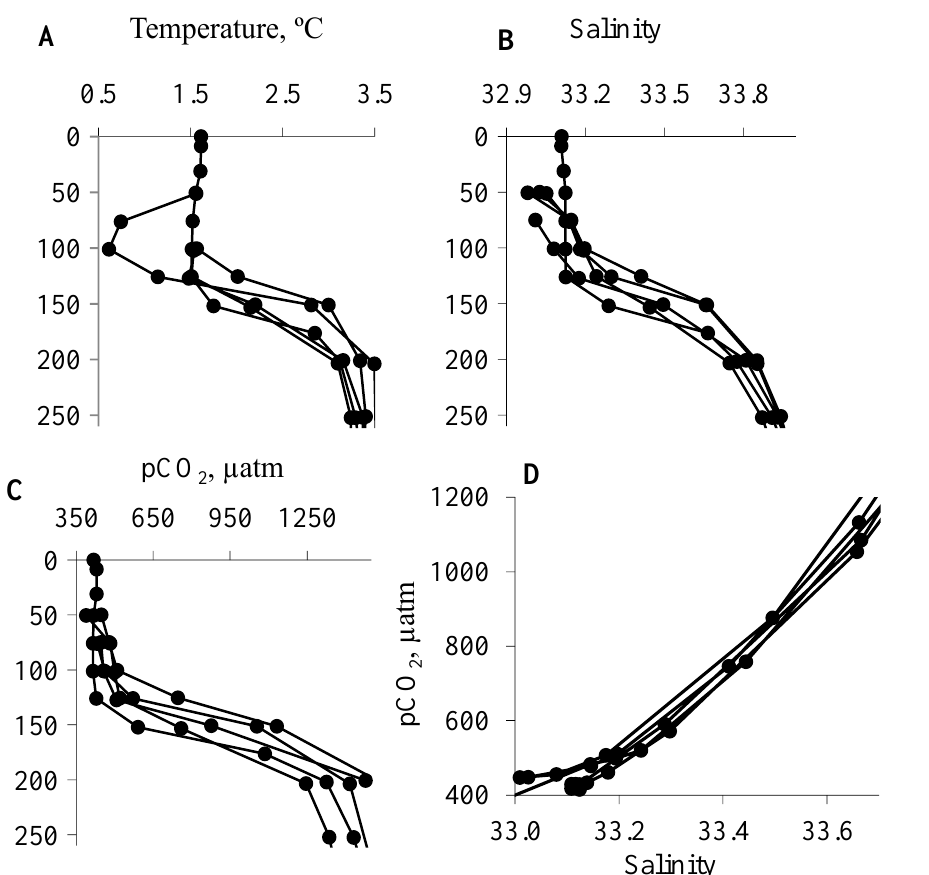
Figure 9. The depth profiles of the temperature, salinity, and pCO 2 ( A – C ) and pCO 2 versus salinity ( D ) (47 ◦ N, 160 ◦ E, winter–spring 2010, 2012, and 2013). Distributions of the temperature, salinity, and pCO 2 in the surface waters of the cen- tral Kuril Islands in January – March 1999, February – March 2000, February 2018, and Feb- ruary 2020 (Figures 6 and 7) were determined by the location and intensity of the Kuril eddies and the EKC stream jet. Increased values of pCO 2 (450 – 480 µatm) in the Kruzenshterna Bank area (Figure 6C: 154° – 155° E) were observed in late January – early